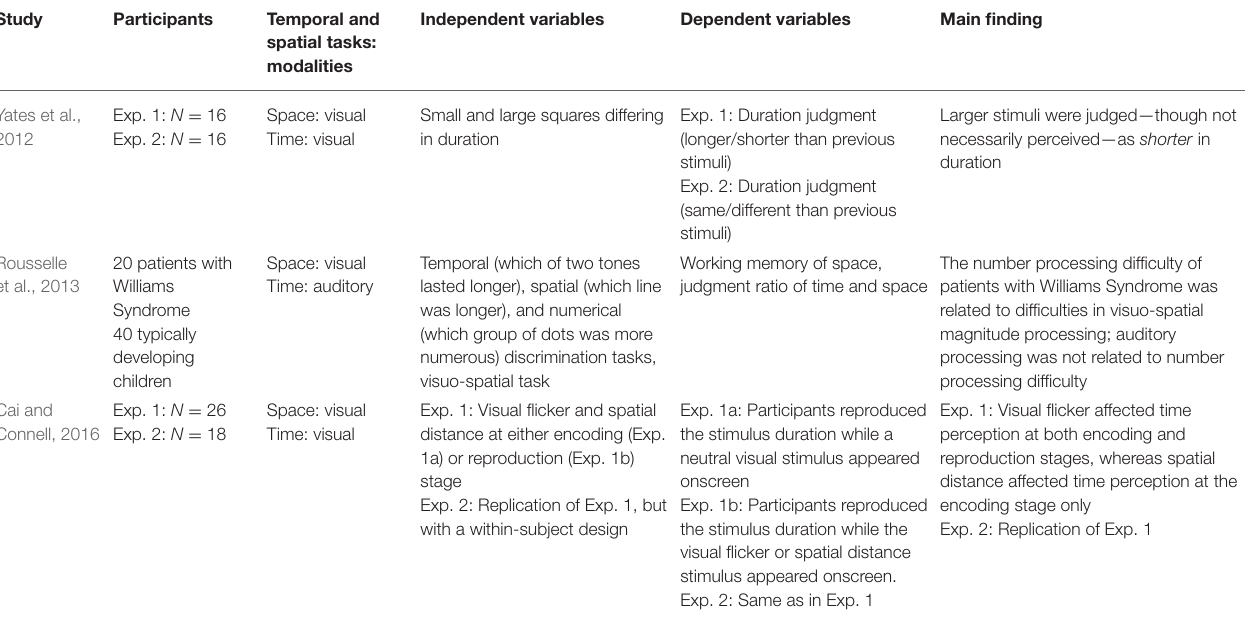
TABLE 3 | Studies examining temporal and spatial representations, but suggesting neither an asymmetric or symmetric time-space mapping.